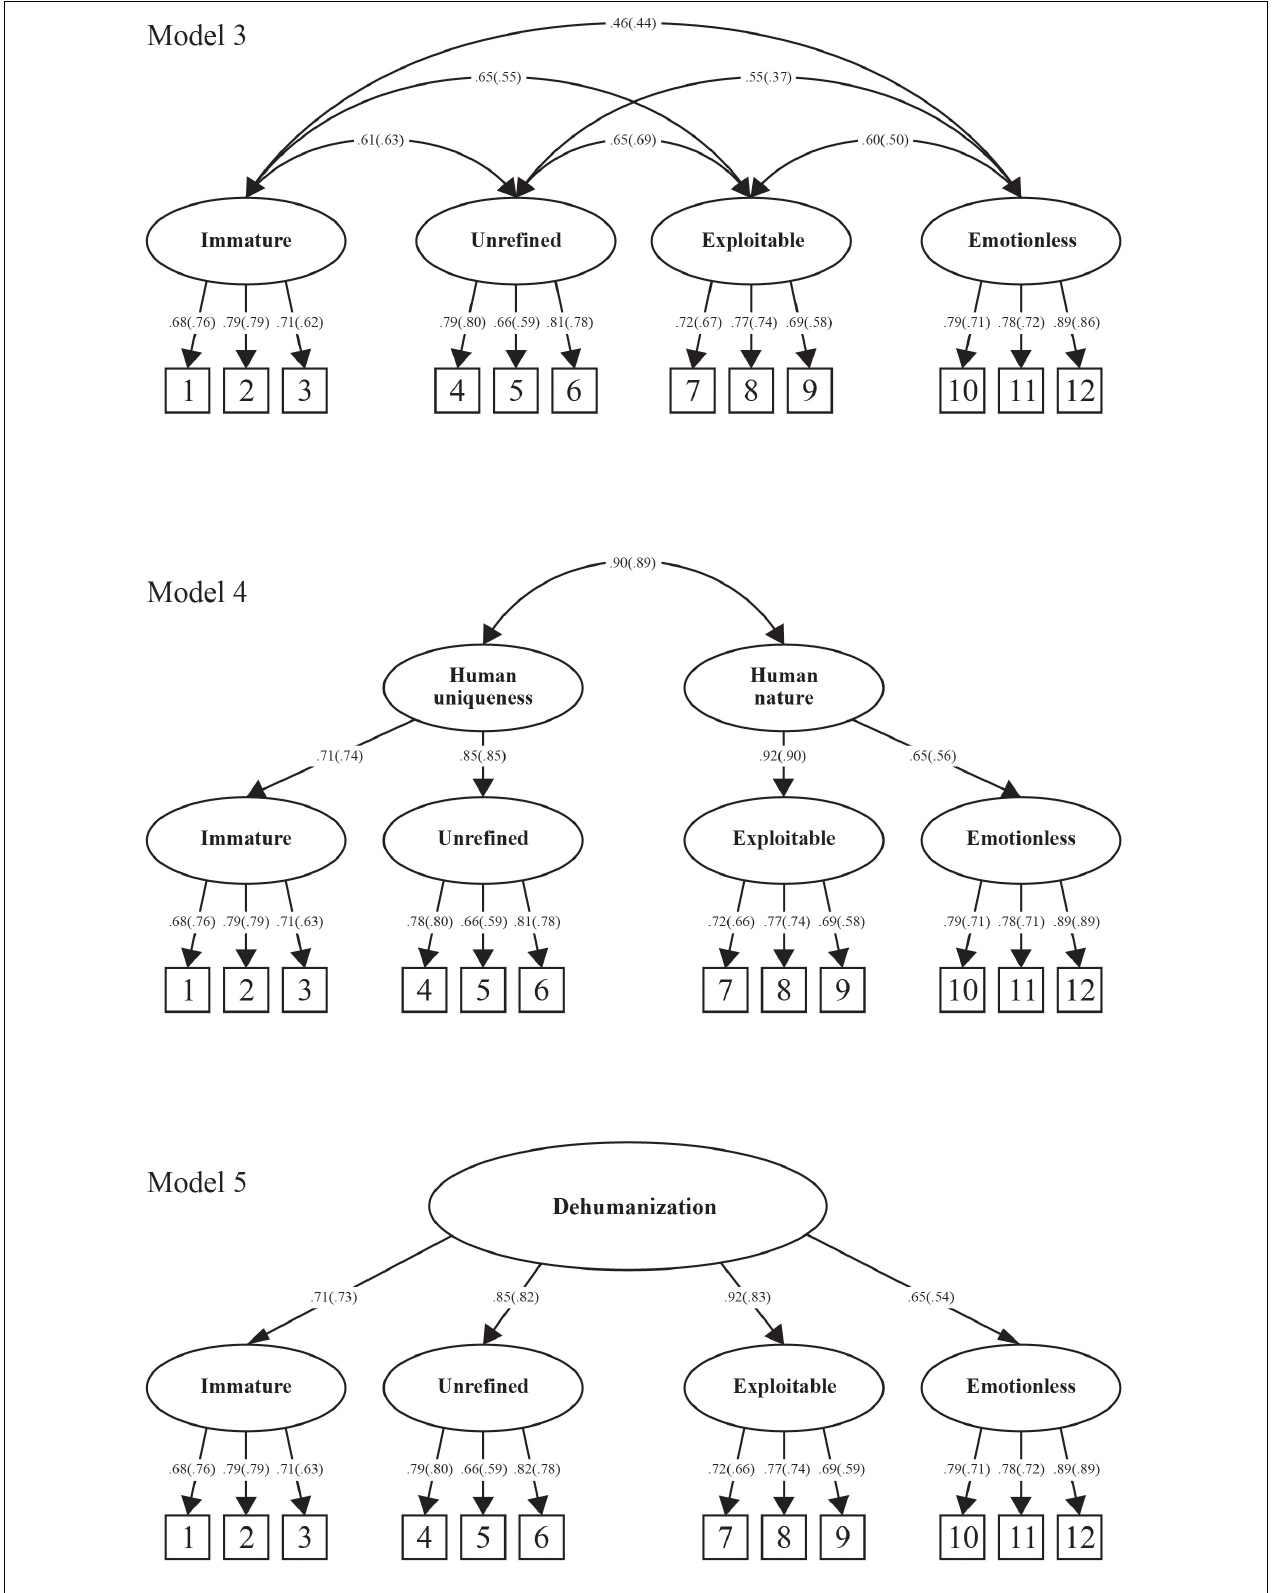
FIGURE 2 | New conceptualizations of interpersonal dehumanization. Standardized factor loadings and covariances for perpetration items are presented in parentheses.